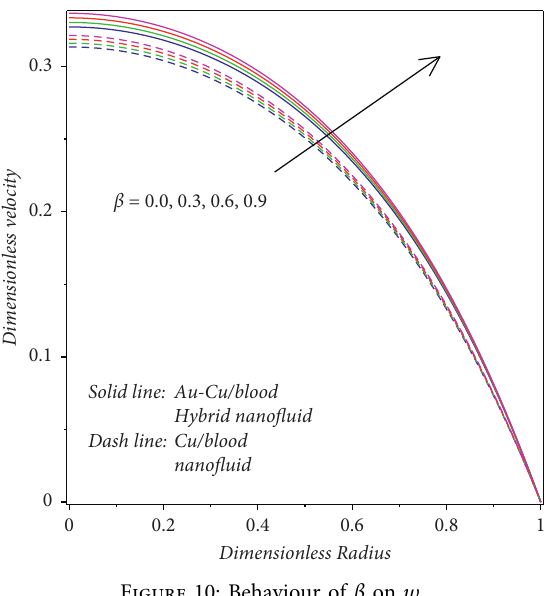
Figure 12: Behaviour of η